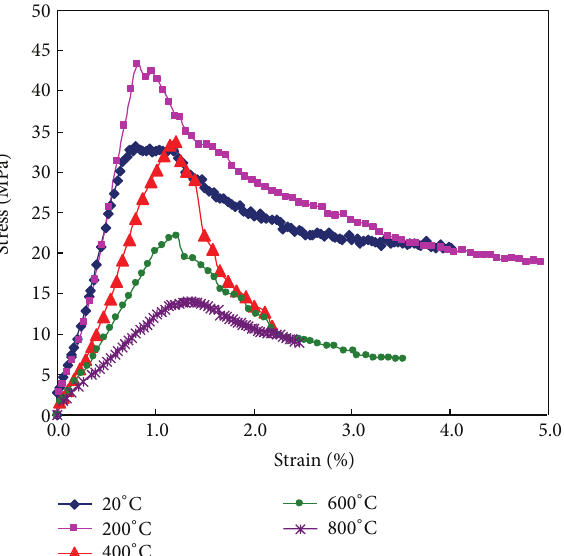
Figure 9: Post-fire specimens cooling in the air.